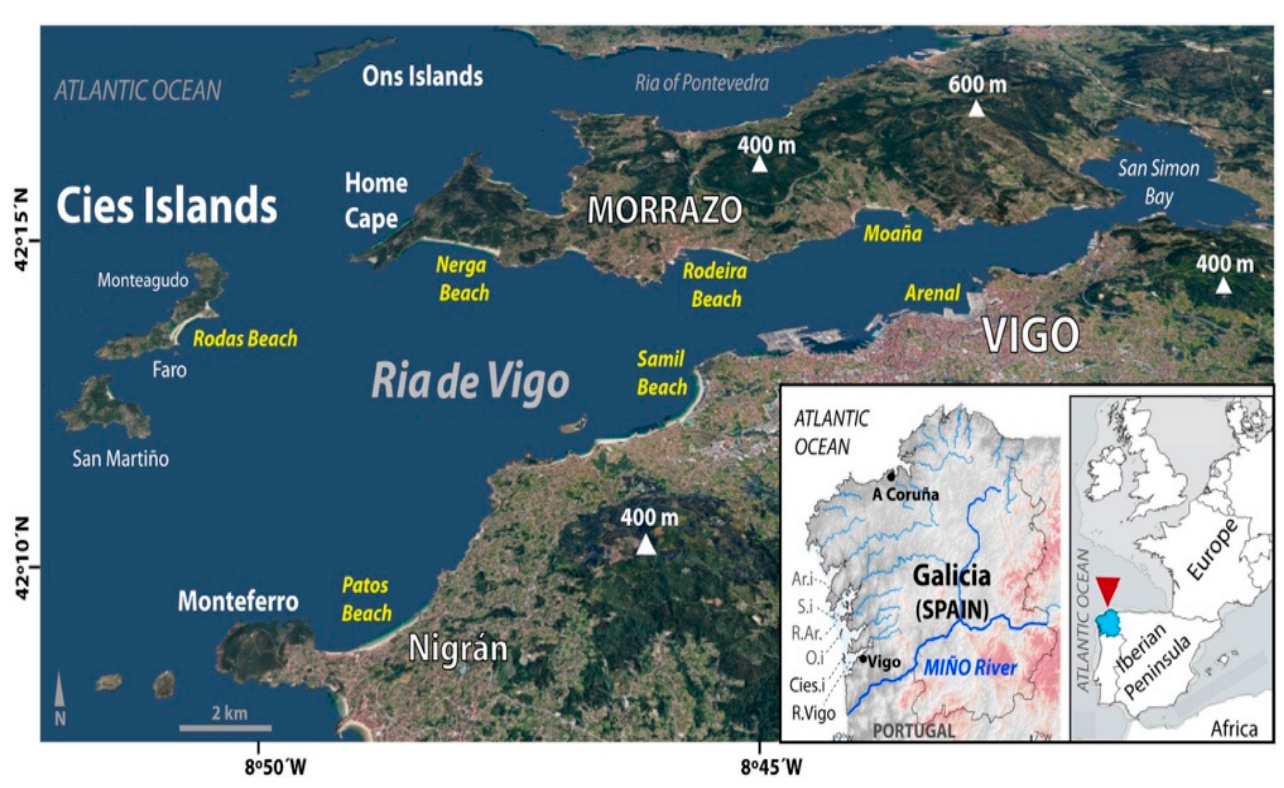
Figure 1. Present day configuration of the Cies Islands and Ria de Vigo showing the main sand beaches (Rodas, Patos, Nerga, Samil, Rodeira and Moaña) related to dune fields and climbing dunes, as examples of aeolian deposits. R.Vigo: Ria de Vigo; Cies.i: Cies Islands; O.i: Ons Islands; R.Ar.: Ria de Arousa; S.i: Sálvora Island; Ar.i: Areoso islet.